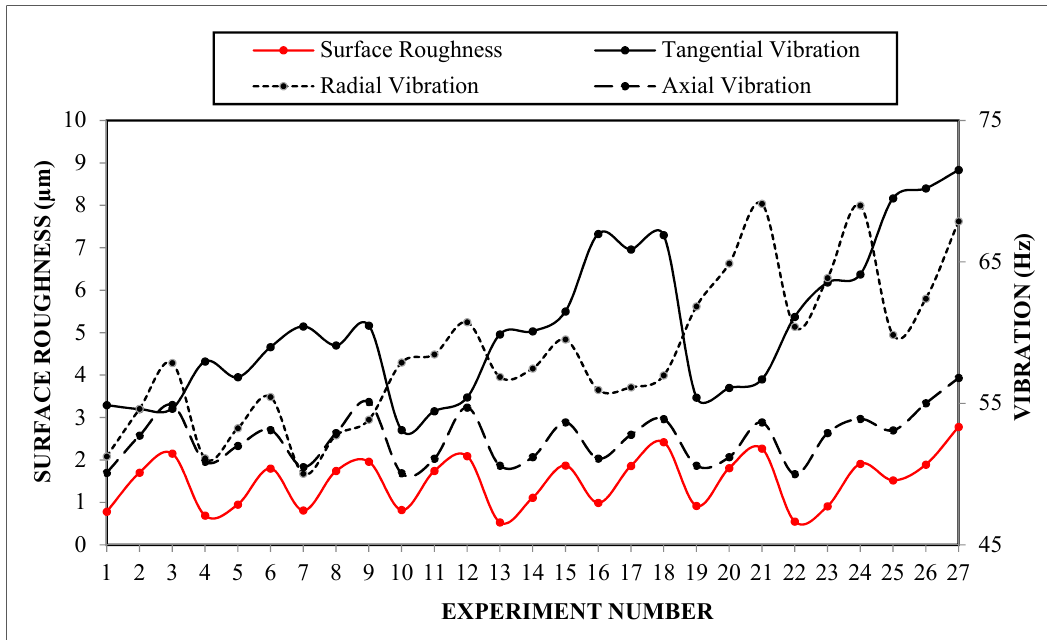
Figure 6. Interaction between surface roughness and vibration components.